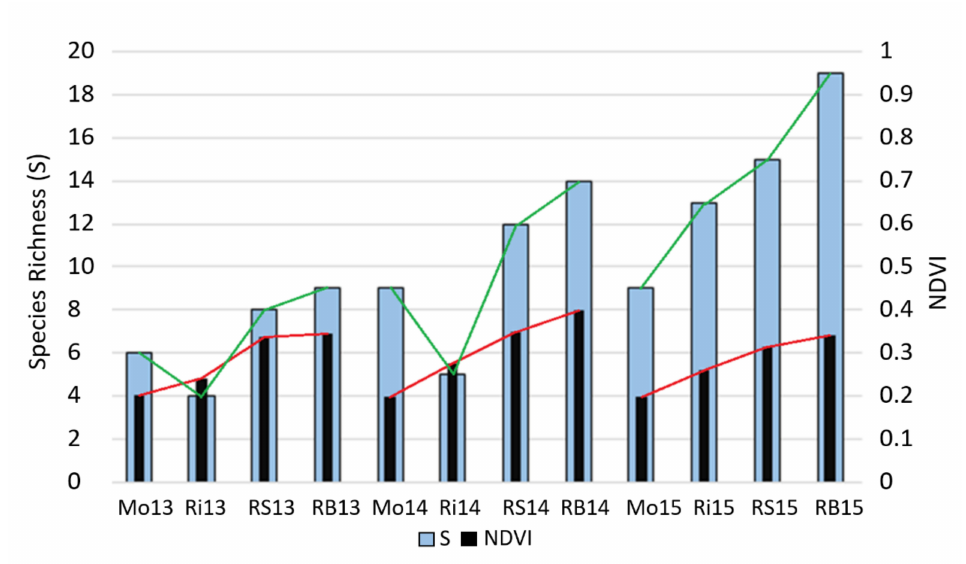
Figure 4. Species richness and NDVI in the four AOPs during 2013, 2014, and 2015. AOPs: Mo: Monterrei, Ri: Ribeiro, RS: Ribeira Sacra, RB: R í as Baixas.